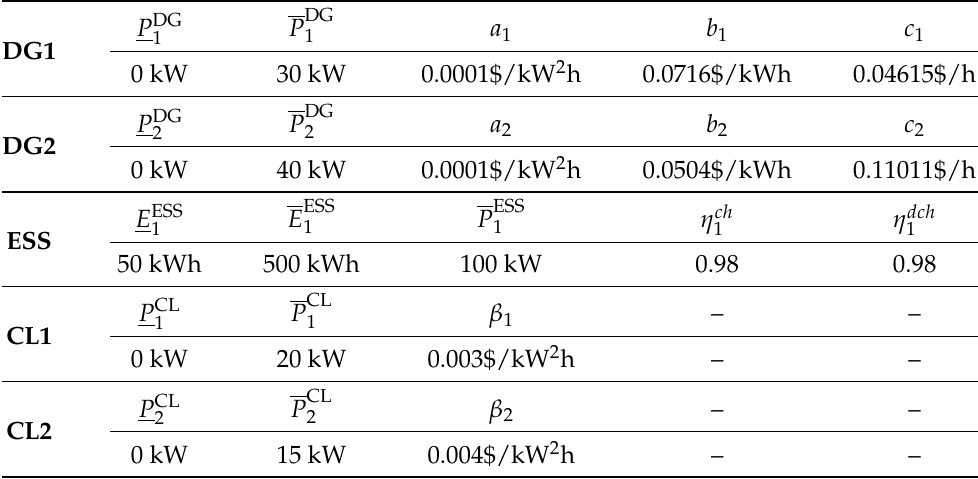
Figure 2. The architecture of CIGRE low-voltage Microgrid. Table 1. Parameters of the controllable devices in the